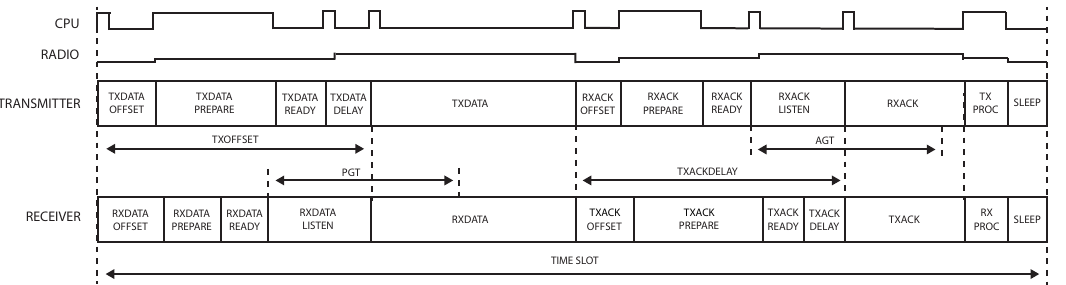
Figure 3. States in TxDataRxAck (transmitter) and RxDataTxAck (receiver) time slots, together with the CPU and radio activity in the TxDataRxAck time